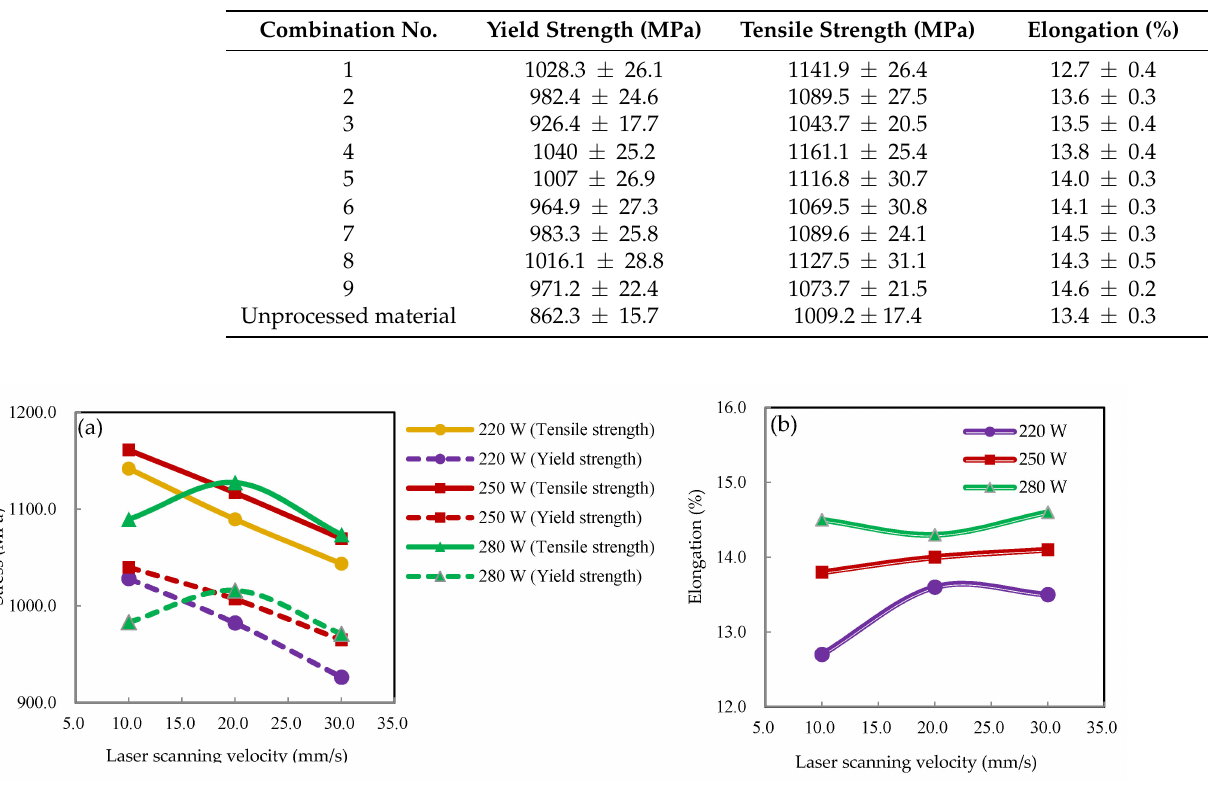
Table 2. Monotonic tensile properties of the specimens.